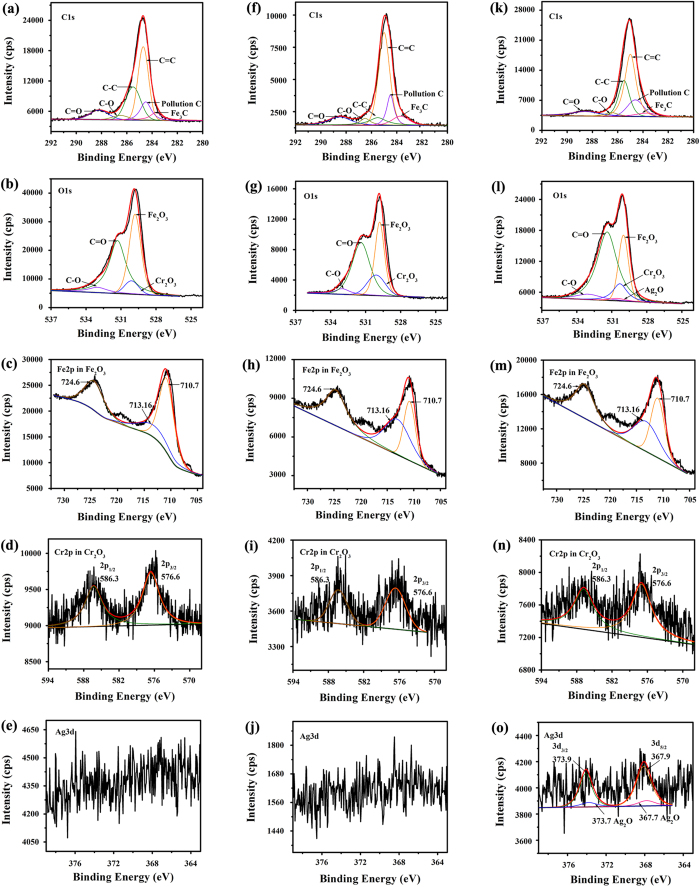
Curve-fitted XPS spectra of typical elements (C1s, O1s, Fe2p, Cr2p, Ag3d) on the wear surface lubricated by 10w40+0.1 wt.% Sc-Ag/GN nano-oil after sliding for different times (343 N, 1200 rpm, 75 ± 1 °C).(a–e) 5 mins, (f–j) 40 mins, (k–o) 60 mins.